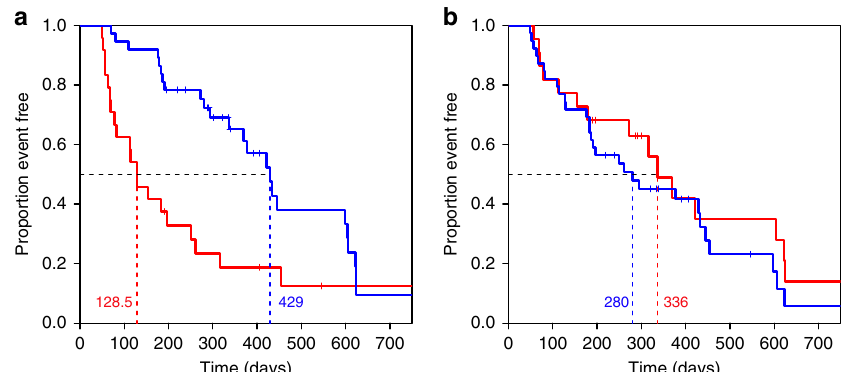
Fig. 6 Kaplan – Meier curves of C + T- or T-treated breast cancer patients strati fi ed by poly-ligand pro fi ling or by tumour Her2 status. a Kaplan – Meier curve of C + T- or T-treated breast cancer patients strati fi ed by poly-ligand pro fi ling. The shortest distance between the ROC curves to point (speci fi city and sensitivity = 100%) determines the cutoff of test positive and negative and is represented as the blue point in Fig. 5c (Sensitivity: 78.6%; Speci fi city: 73.7%). “ Event ” is de fi ned as the time point (days) at which a patient either deceased from cancer or at which trastuzumab-based treatment changed. Median time of bene fi t is 429 days for patients tested positive (blue, n = 37, event = 25) and 129 days for patients tested negative (red, n = 24, event = 20). HR = 0.384, 95% CI: 0.21 – 0.70; log-rank p = 0.001. The small vertical lines mark cases that were censored due to absence of treatment follow-up data (Supplementary Data 4). b Kaplan – Meier curve of C + T- or T-treated breast cancer patients strati fi ed by tumours ’ HER2 status. HER2 status of patients with both HER2 IHC and HER2 ISH test results was determined according to ASCO guidelines 36 . Median time of bene fi t is 280 days for HER2 positive cases (blue, n = 39, event = 29), and 336 days for HER2-negative/equivocal cases (red; n = 22, event = 16). HR = 1.27, 95% CI: 0.68 – 2.37; log- rank p =